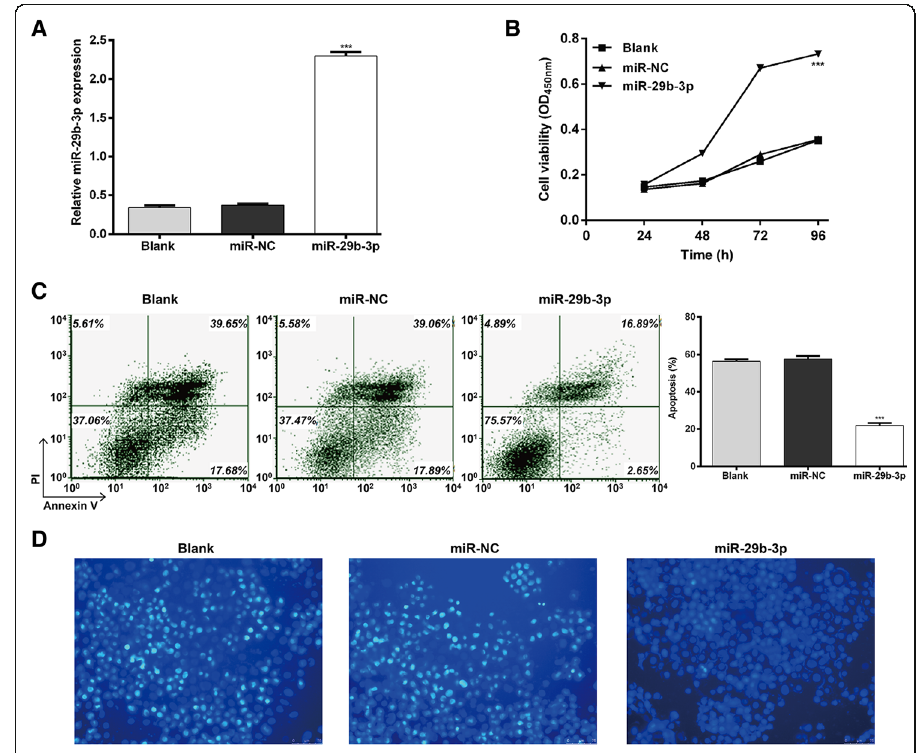
Fig. 2 Hypoxia-induced AC16 cell injury is attenuated by miR-29b-3p overexpression. AC16 cells were transfected with miR-29b-3p or miR-NC before culture under hypoxic conditions. Non-transfected AC16 cells were cultured under normoxic conditions as a blank group. a – The expression of miR-29b-3p was detected using quantitative real time PCR. b – CCK-8 assay was performed to measure cell viability. c and d – Flow cytometry with Annexin V/PI staining and Hoechst 33258 staining were used to assess cell apoptosis. Each experiment was repeated three times. *** p < 0.001 vs. miR-NC or